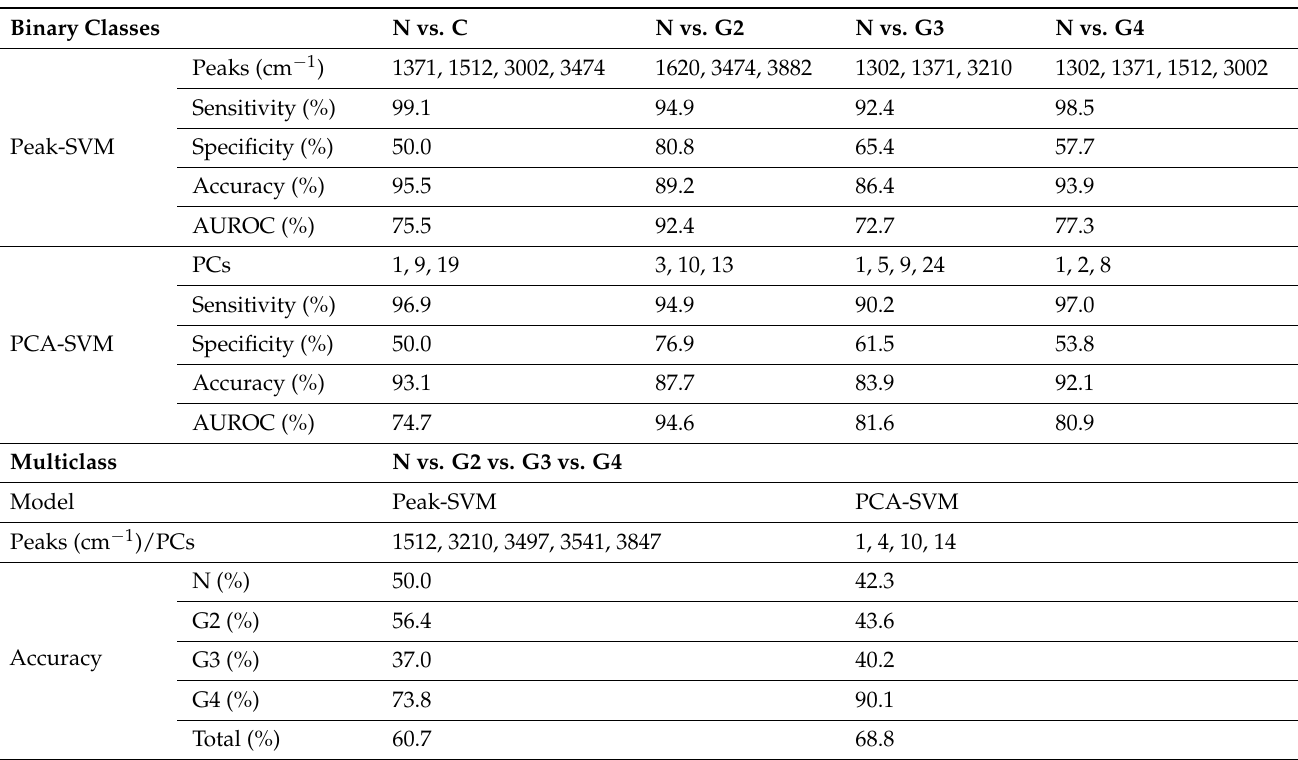
Table 2. Peak-SVM and PCA-SVM classification